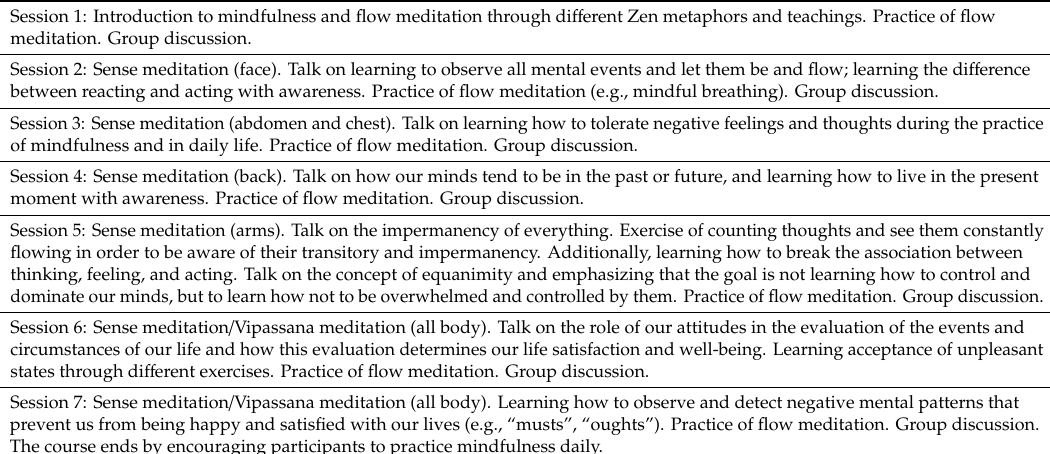
Table 1. Contents of the flow meditation program by